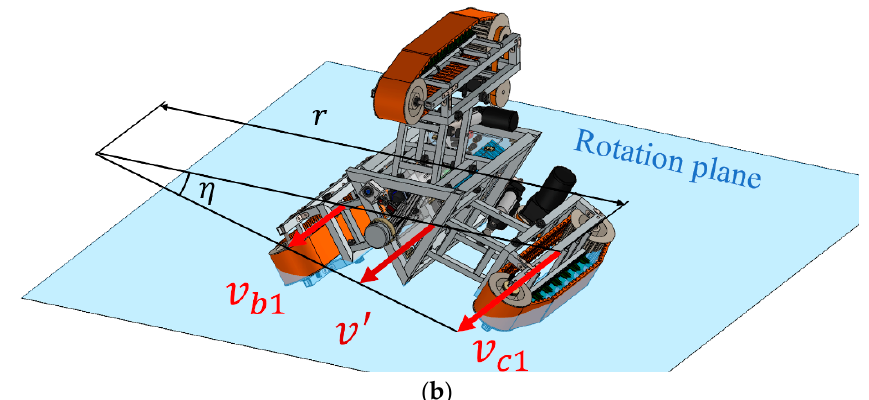
Figure 7. ( a ) Three-crawler differential speed strategy; ( b ) planar schematic of differential steering.